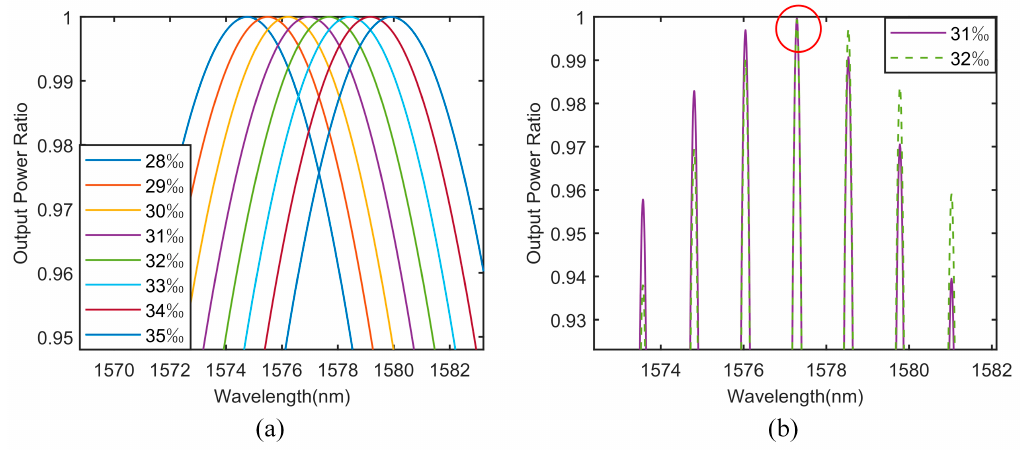
Figure 3. Details of the output spectra with salinity ( a ) at peak1 with arm difference l a = 0 mm, and ( b ) at peak2 with arm difference l a = 3 mm.